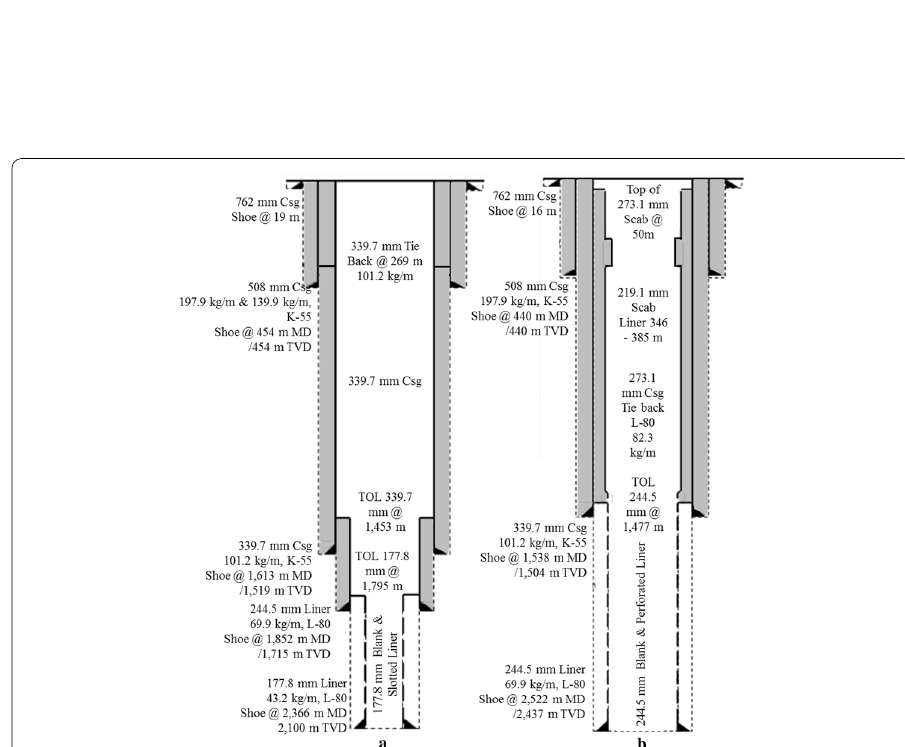
Fig. 3 Well schematic of a HCE9B and b HCE28B (Marbun 2013; PT Geo Dipa Energi